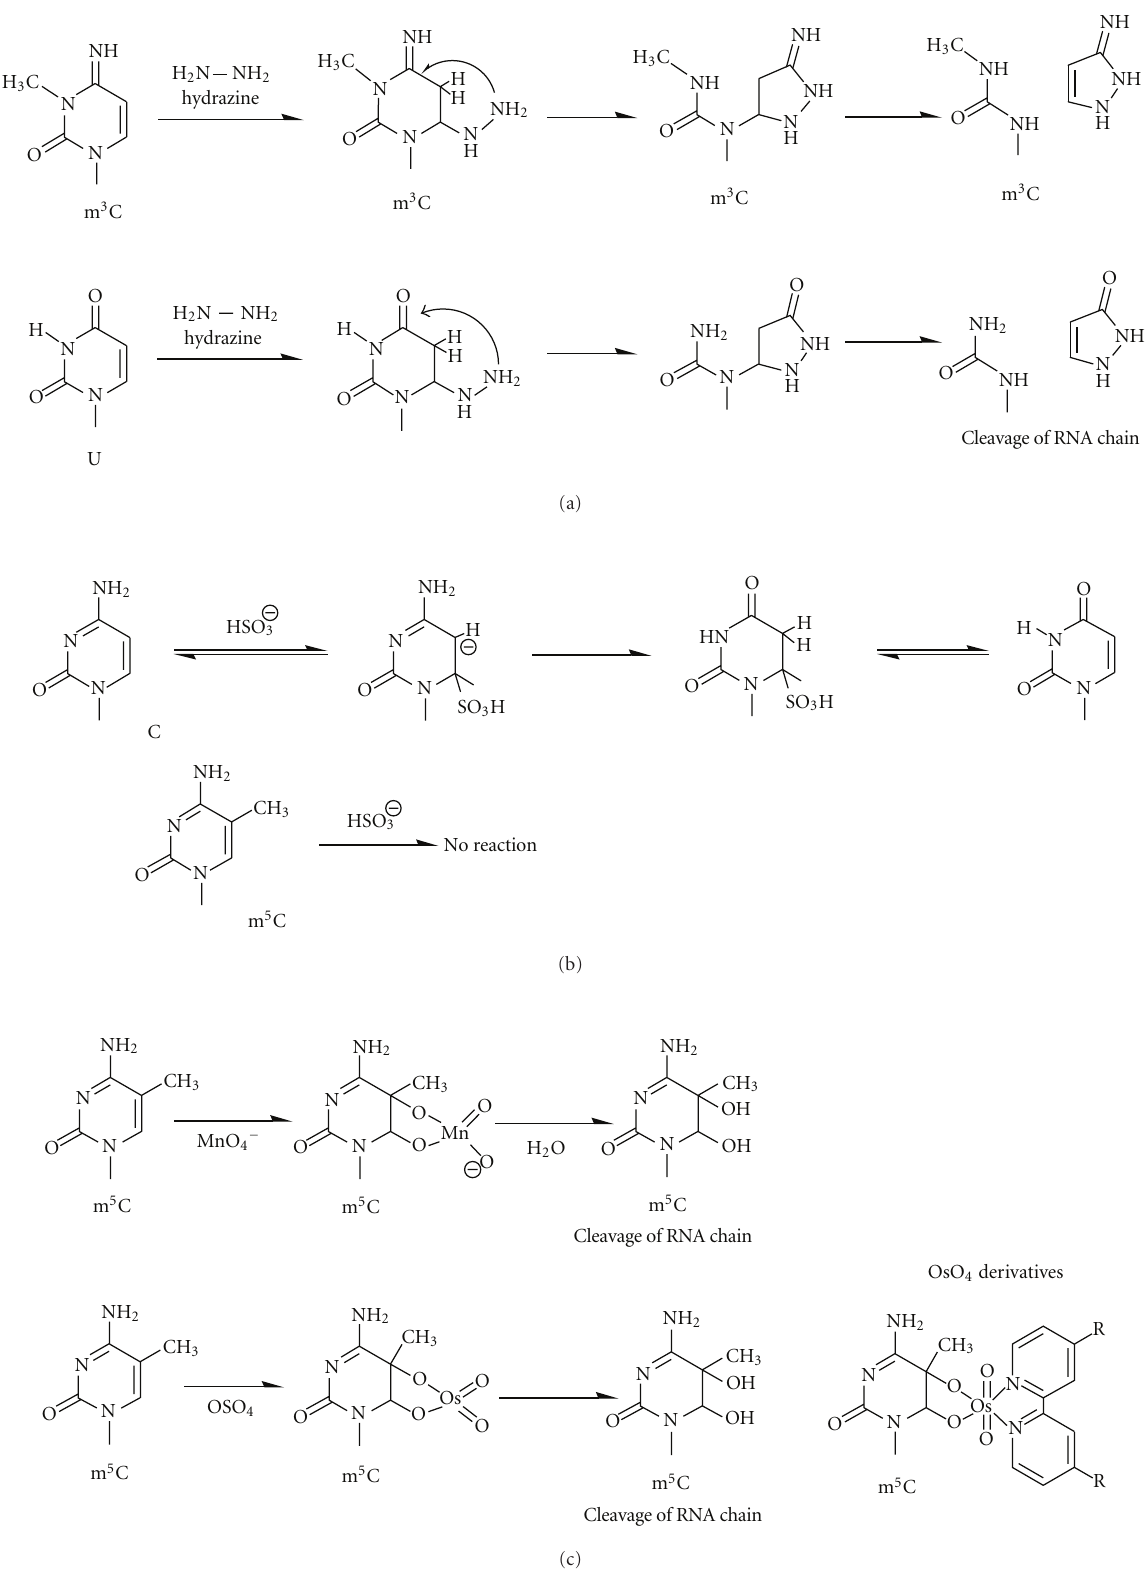
Figure 2: Specific chemical reactions for m 3 C and m 5 C detection. (a) Cleavage of m 3 C and unmodified uridine by hydrazine. (b) Deamination of unmodified cytosine by bisulfate; m 5 C is resistant for deamination. (c) Specific oxydation of 5-6 double C = C bond in methylated pyrimidines by MnO 4 − , OsO 4 , and OsO 4